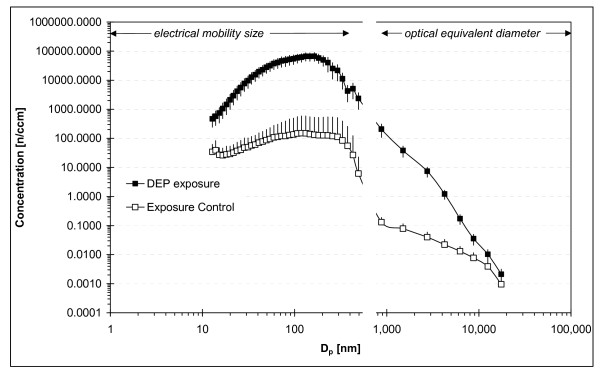
Average particle number distribution during DEP-exposure compared to the average particle size distribution in exposure to controls.n = 26. Error bars denote the SD of the average concentrations calculated based on the average for each N exposure.